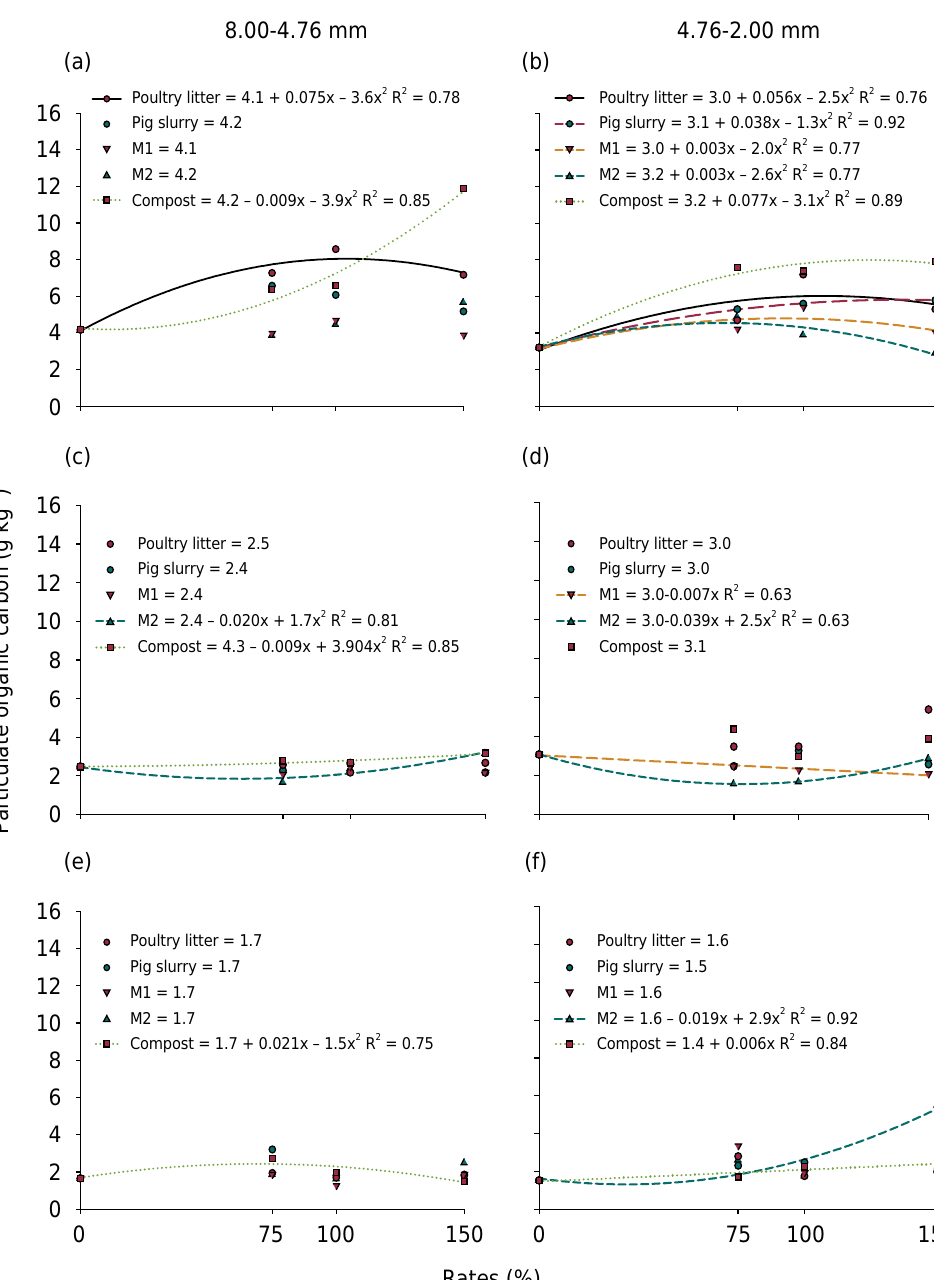
M1: mineral fertilizer 1, equivalent to pig slurry; M2: mineral fertilizer 2, equivalent to poultry